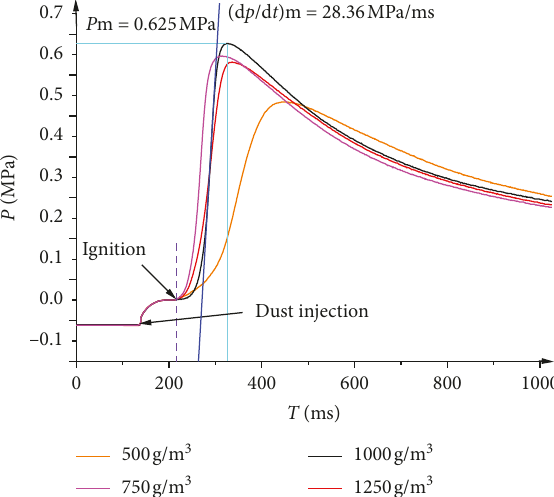
Figure 3: The explosion curves of oil shale dust at different concentrations.